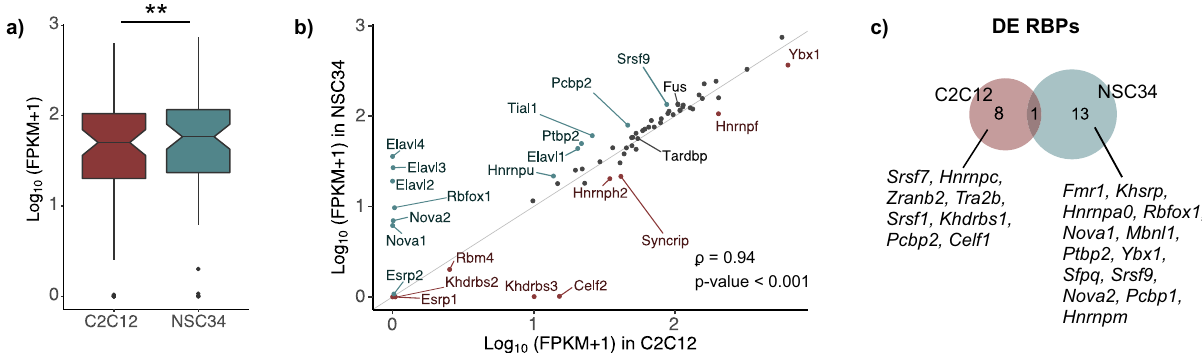
Fig. 5 Expression of RNA-binding proteins in C2C12 and NSC34 cells. a Boxplot shows that NSC34 cells on average display higher expression of 63 RNA- binding proteins 14 compared to C2C12 cells ( p -value = 0.0028). Average expression levels are plotted as log 10 -transformed FPKM values of all 63 transcripts and p -value was generated using Wilcoxon signed-rank test. b Expression of 63 RBPs (plotted as log 10 -transformed FPKM values) in C2C12 and NSC34 cells (Spearman ’ s ρ = 0.94; p -value < 2.2·10 − 16 ). Those with higher expression in one cell line than another (> 150%) are shown in red (C2C12) or blue (NSC34). Grey line represents y = x . c Venn diagram shows RBPs the expression of which changes following TDP-43 reduction. The overlapping event is downregulation of